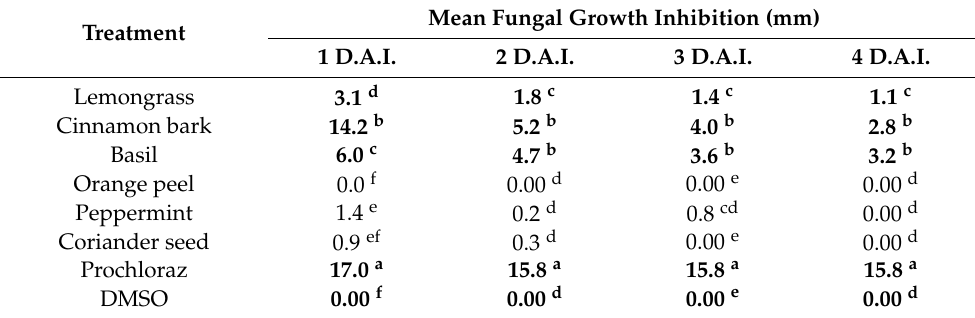
Table 4. The antifungal activity of six tested EOs against C. acutatum